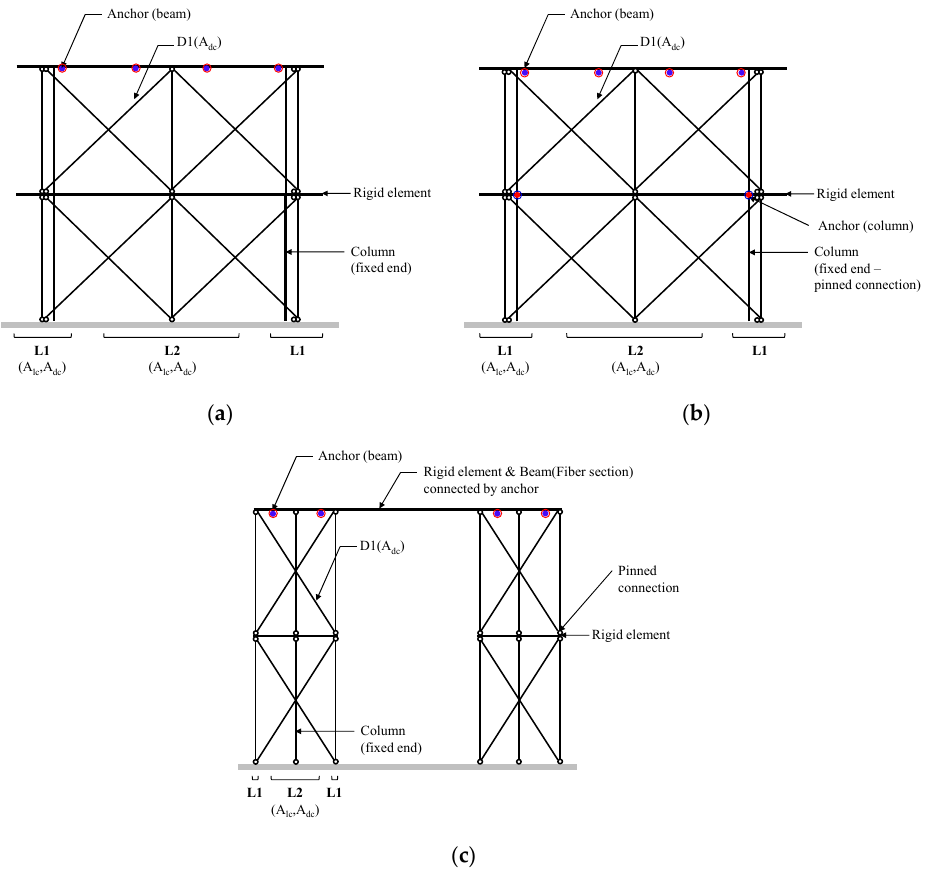
Figure 22. Simplified finite element model of EPCW: ( a ) Specimen FB; ( b ) Specimen FBC; ( c ) Specimen FPB. Table 3. Cross-section of each element for simplified model.